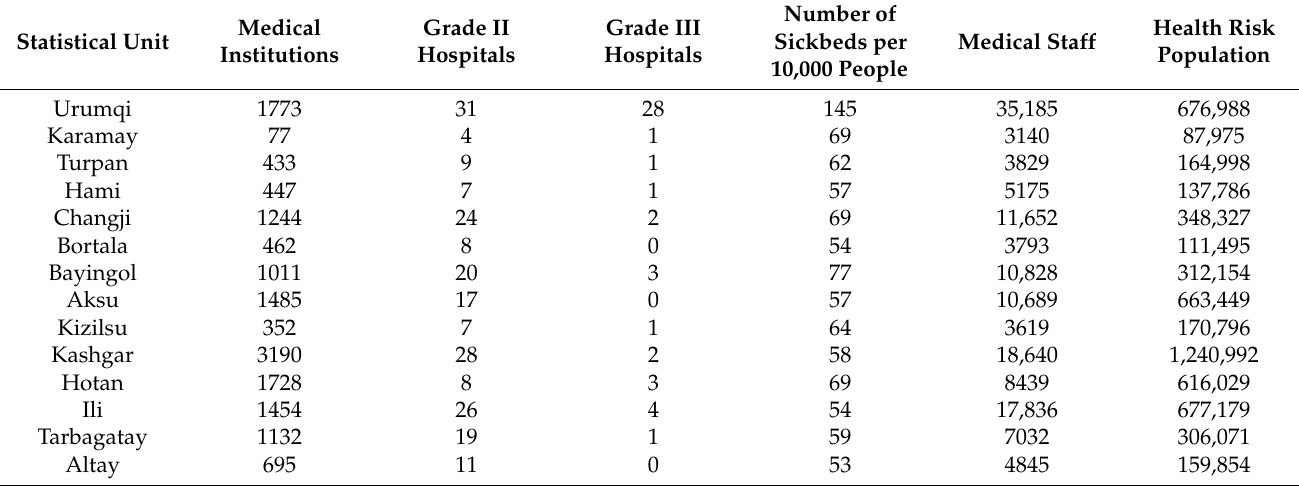
Table A1. Basic medical conditions of all districts in